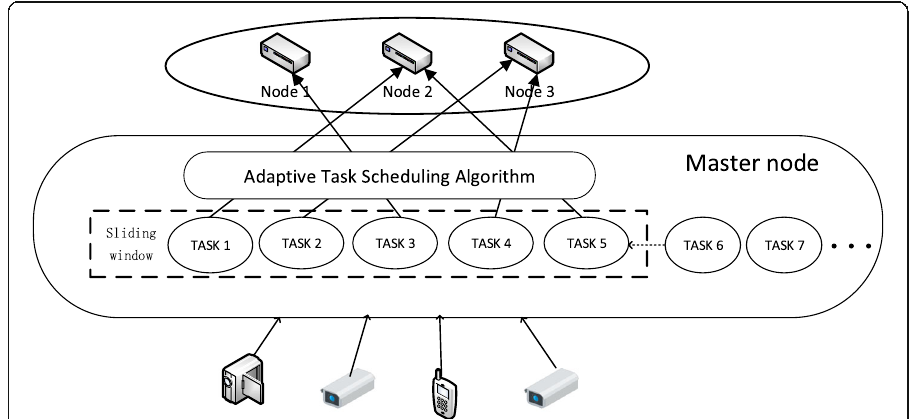
Fig. 3 Task scheduling schematic. How the adaptive task scheduling algorithm optimally schedules tasks on edge